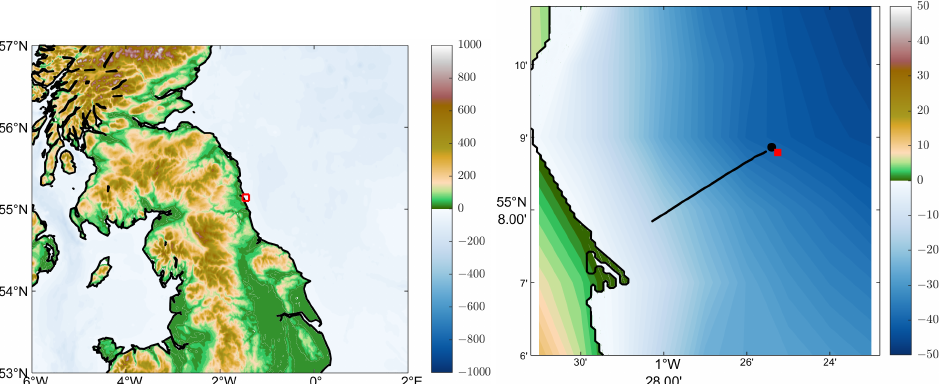
Figure 4. ( left ) The study area near Blyth (UK) in the red rectangle. ( right ) The position of the NOAH meteorological mast (red square), the initial position of the floating lidar (black circle) and the positions recorded by the lidar GPS (black dots) during the measurement period. The colorbar indicates the elevation of the terrain in meters relative to the mean sea